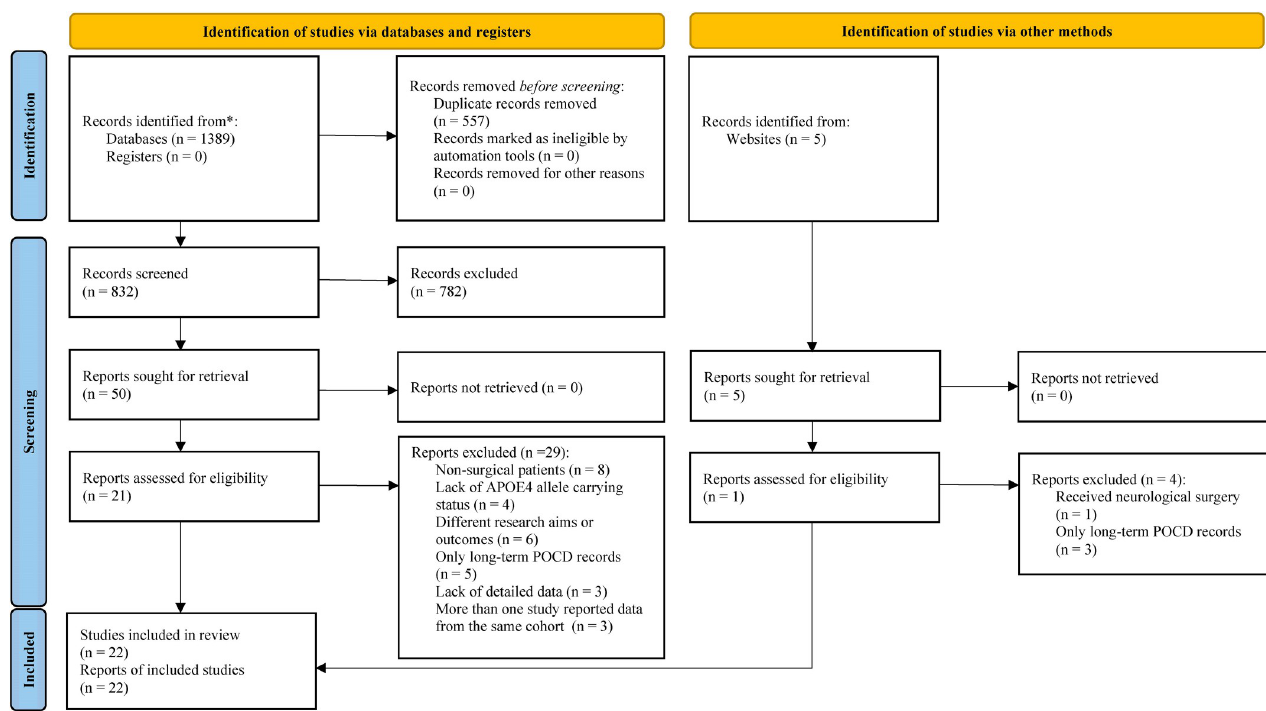
Fig 1. Flow diagram showing study selection